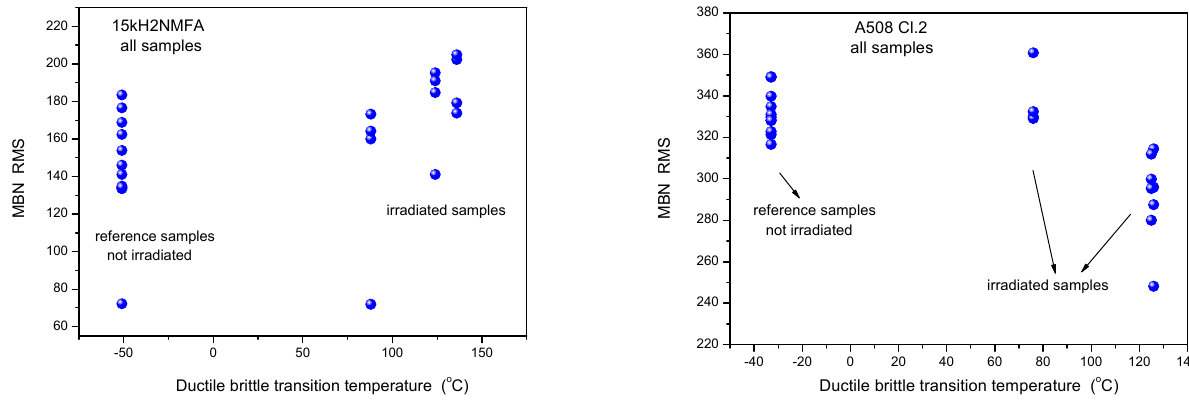
Figure 5. MBN RMS parameter as a function of transition temperature for all measured 15kH2NMFA and A508 Cl.2 samples.